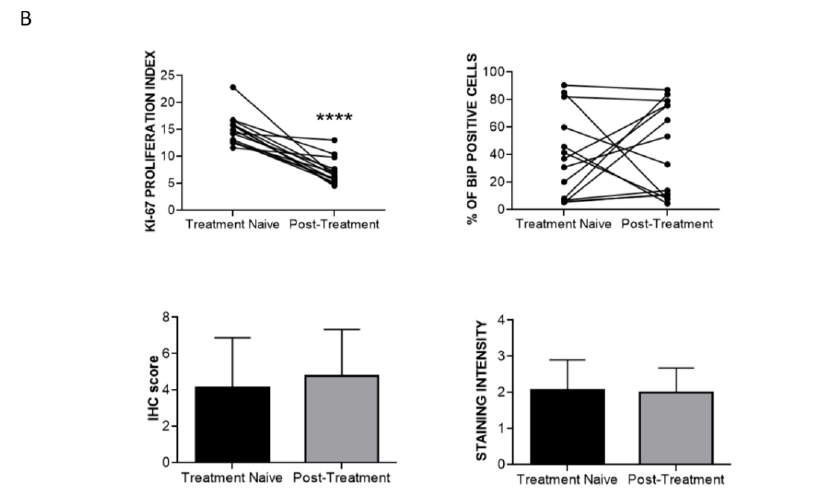
Figure 7. Representative pictures of BiP and Ki67 immunostaining and respective H&E in treatment- nave biopsies vs. their matched post-treatment tumors. ( A ) Arrows indicate cytosolic BiP expression while arrowheads show BiP and Ki67 nuclear localization in neoplastic cells. All pictures were from the same invasive ductal carcinoma case as seen in the corresponding H&E slide showing irregular and angulated tubules infiltrating the breast stroma. Scale bars: 50 µ m ( B ) Graphs comparing % Ki67 index and %BiP positive cells, as well as BiP immunohistochemical (IHC) score in paired treatment-naïve biopsies and post-treatment tumors ( n = 14). ****: p < 0.0001; Wilcoxon paired test. Table 7. Correlation between BiP expression clinicopathological factors in cohort 1. Clinical Factor Cases, No. p -Value Histology